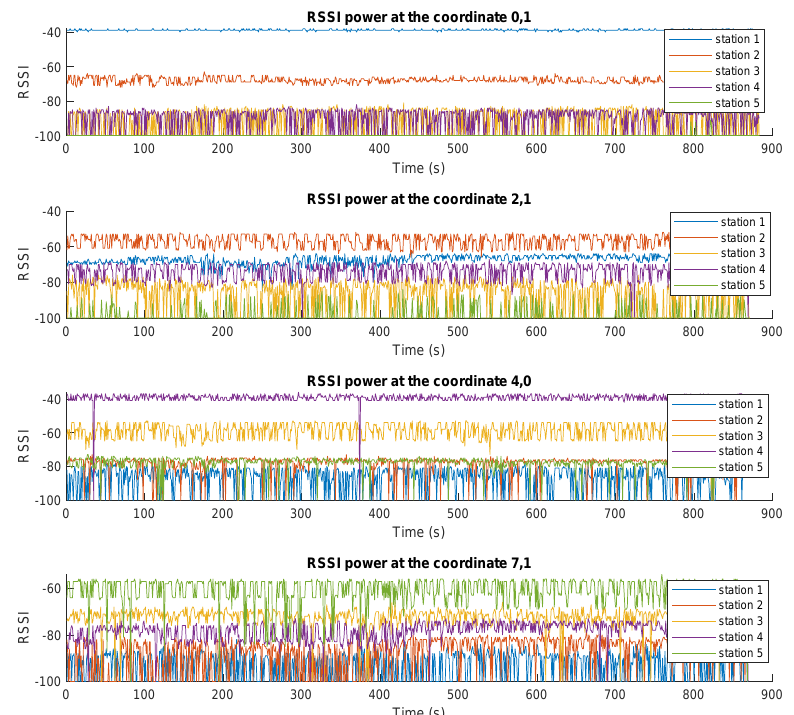
Figure 17. RSSI values received by all five scanning stations for four different locations ( ( 0,1 ) , ( 2,1 ) , ( 4,0 ) , and ( 7,1 ) ).